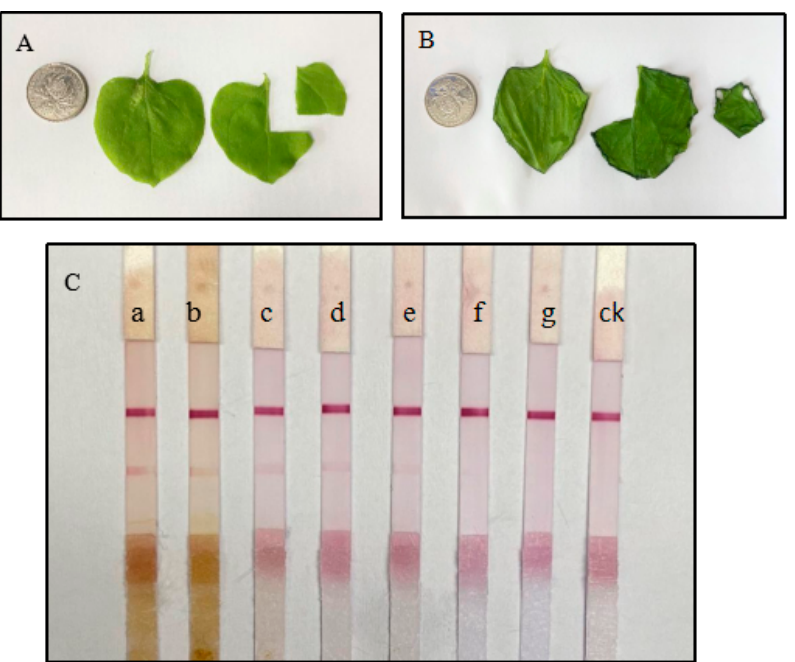
Figure 5. ( A ) Healthy tobacco leaves. ( B ) Inoculated CGMMV tobacco leaves. ( C ) The sensitivity of the test strip to detect CGMMV (disease sample quality, w, and bu ff er dilution ratio, v). (a) 1:1, (b)